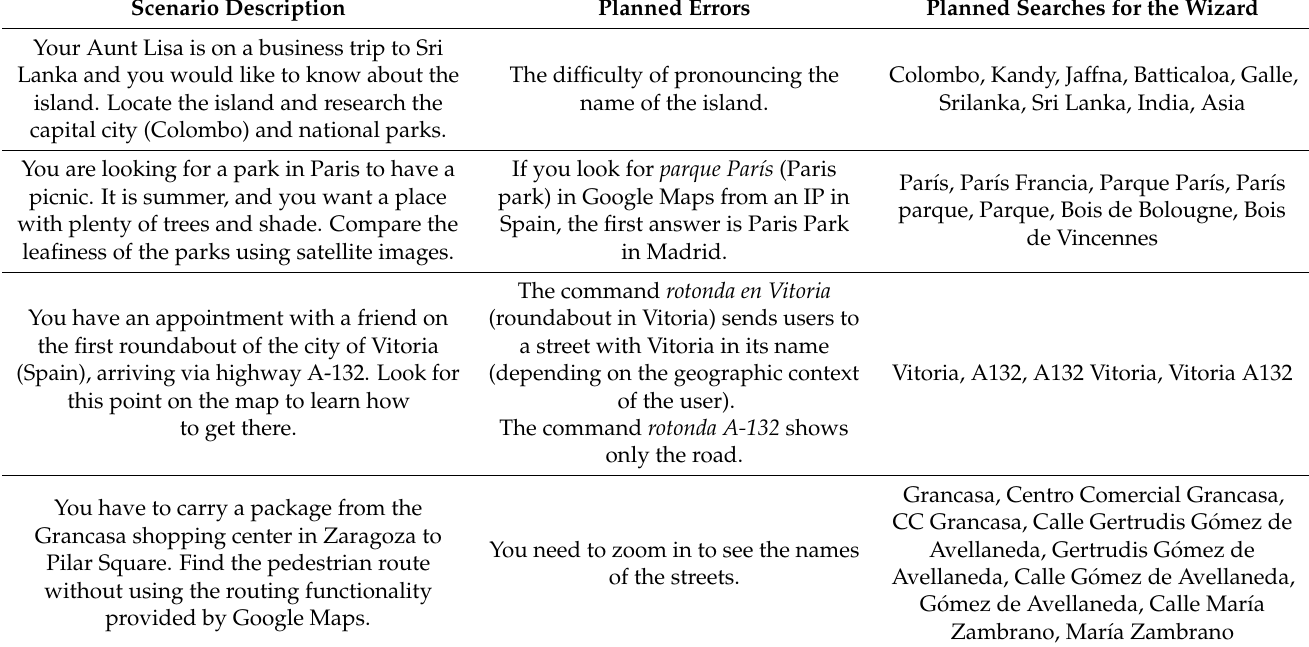
Table 2. Wizard of Oz Scenarios, Predicted Errors, and Error